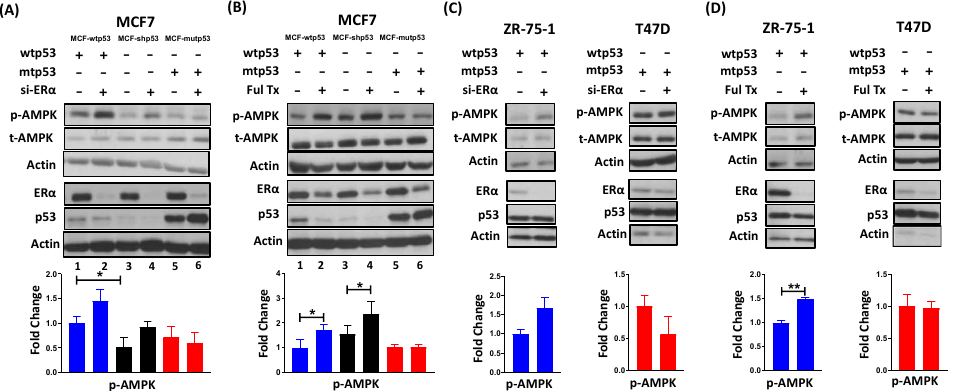
Figure 1. Requirement for repression of AMPK phosphorylation by ER α in LBC is dependent on p53 status (wild type p53 versus mutant p53). MCF7 isogenic cells differing in their p53 status (MCF7-wtp53, MCF7-shp53, and MCF7-mutp53) ( A , B ), ZR-75-1, and T47D ( C , D ) were treated with ( A , C ) siRNA (25 nM) targeting ER α or ( B , D ) Fulvestrant (100 nM) for 48 h. Subsequently, cells were lysed, and immunoblotting analysis was performed to probe for AMPK phosphorylation (p-AMPK), ER α , p53, and actin. Panels below each immunoblot represent graphical representation of densitometric analysis of p-AMPK levels normalized to actin and then to non-specific silencing siRNA/Vehicle treatment. Values reflect mean ± standard deviation of at least three biological replicates. * p -value < 0.05, demonstrate statistical significance by One-way ANOVA ( A , B ). ** p -value < 0.01, demonstrate statistical significance by Students t -test ( C , D ). Quantitation of protein expression levels of total AMPK (t-AMPK) (Figure S1-Part A), ER α (Figure S1-Part B), and p53 (Figure S1-Part C) are in the Supplementary section. wtp53: wild type p53; mutp53: mutant p53; Ful: Fulvestrant.